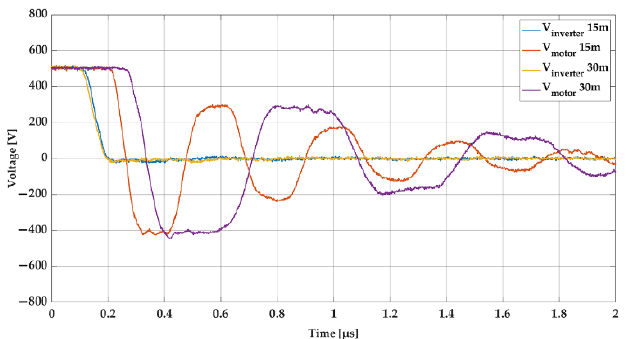
Figure 4. Voltage waveform across the inverter and the motor during the turn-on.